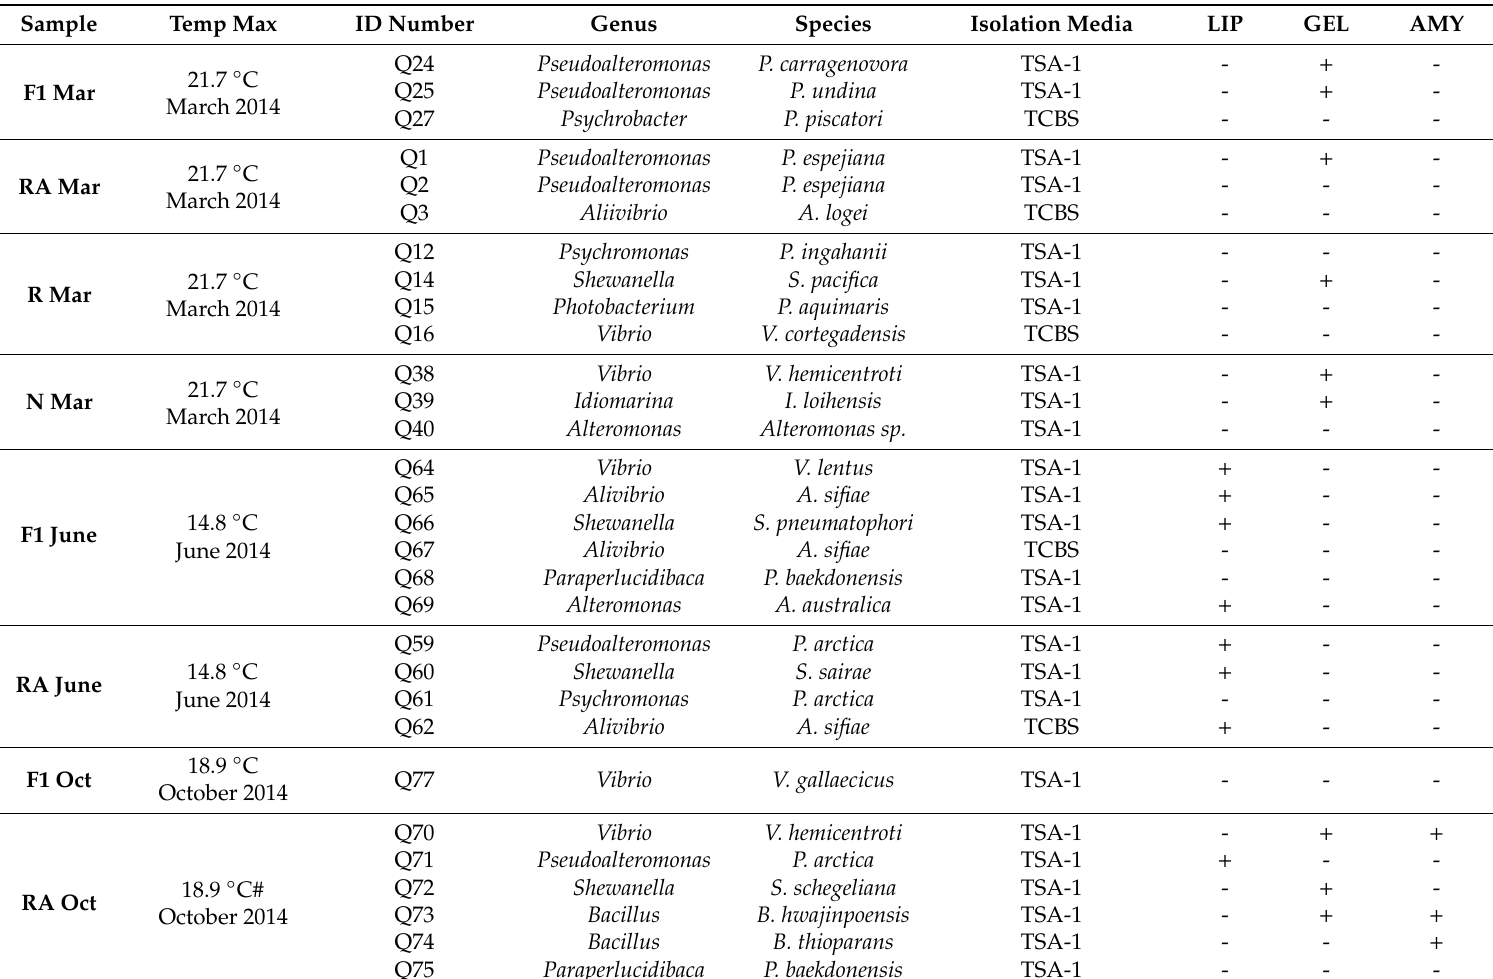
Table 1. Characteristics of isolates recovered in this